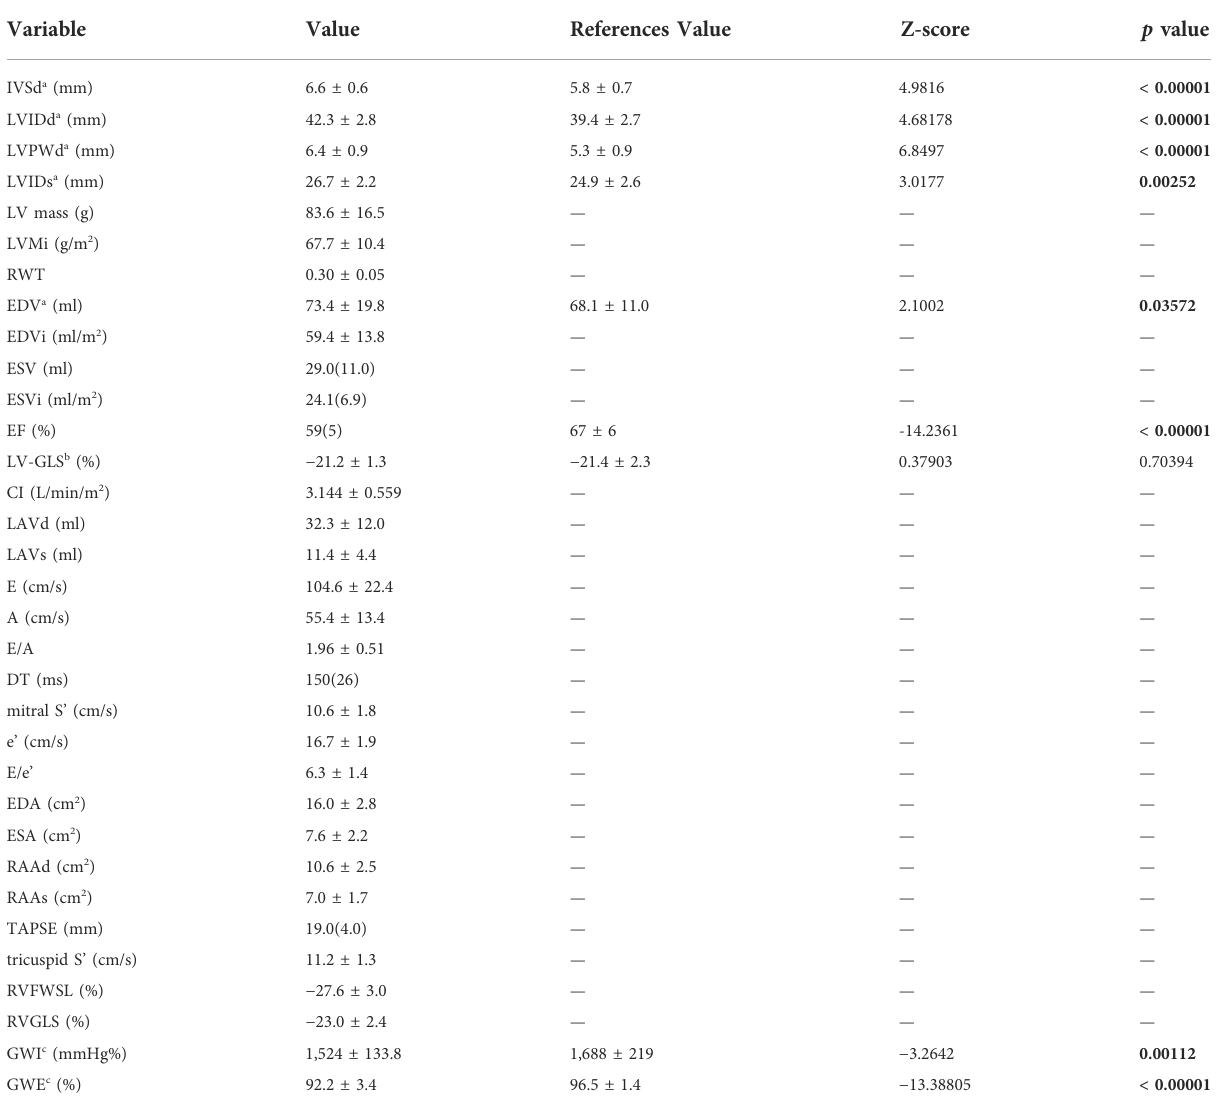
TABLE 3 2D echocardiographic